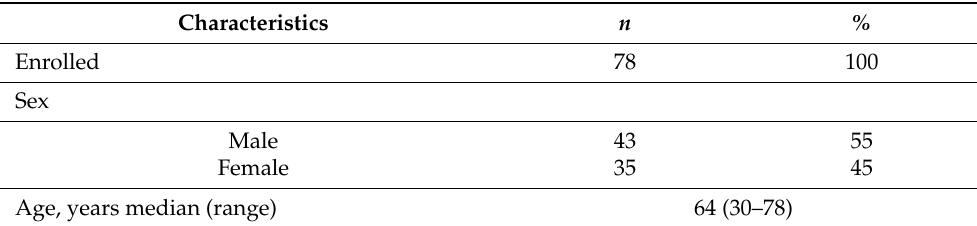
Table 1. Patient